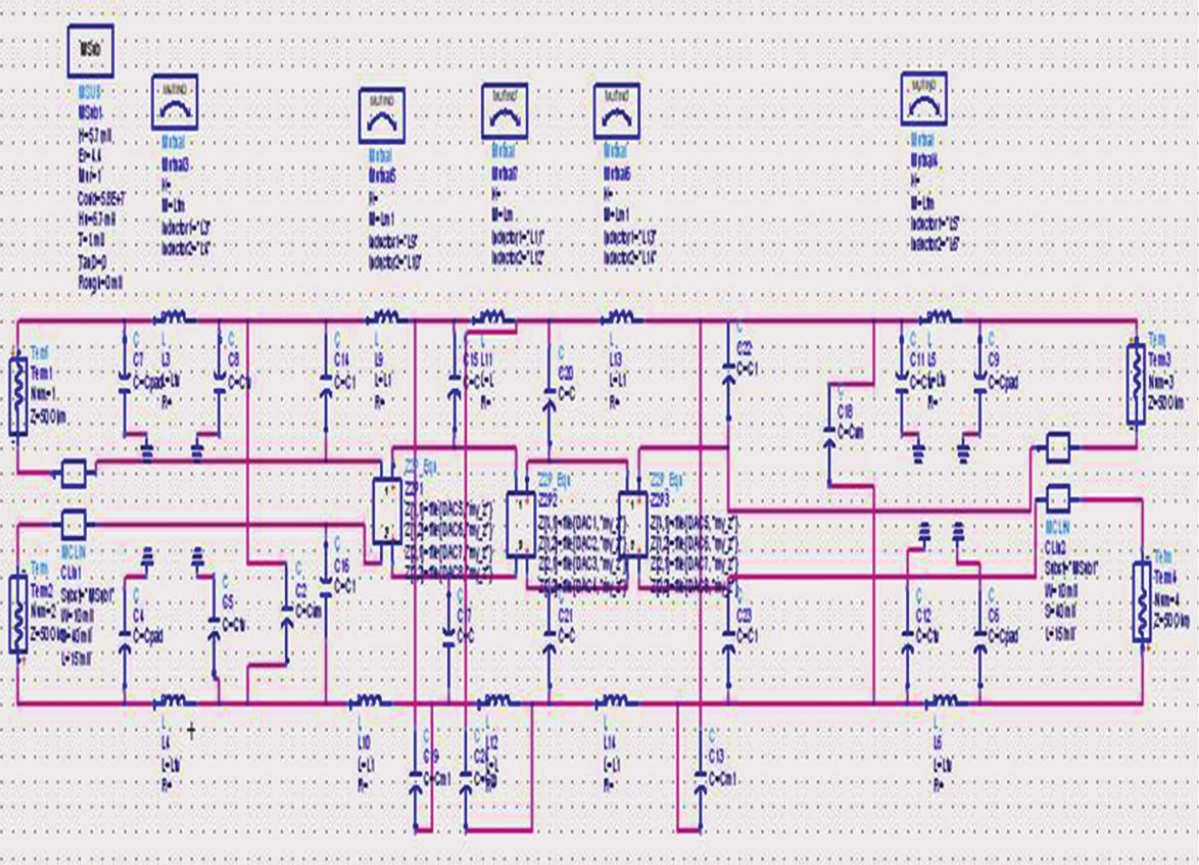
Figure 22: Equivalent circuit model of differential vias in multilayer.